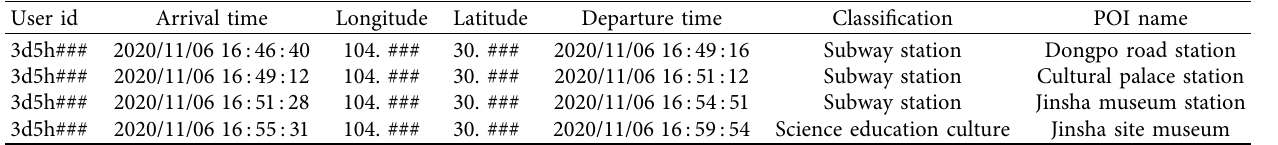
Table 1: Example of scene data.